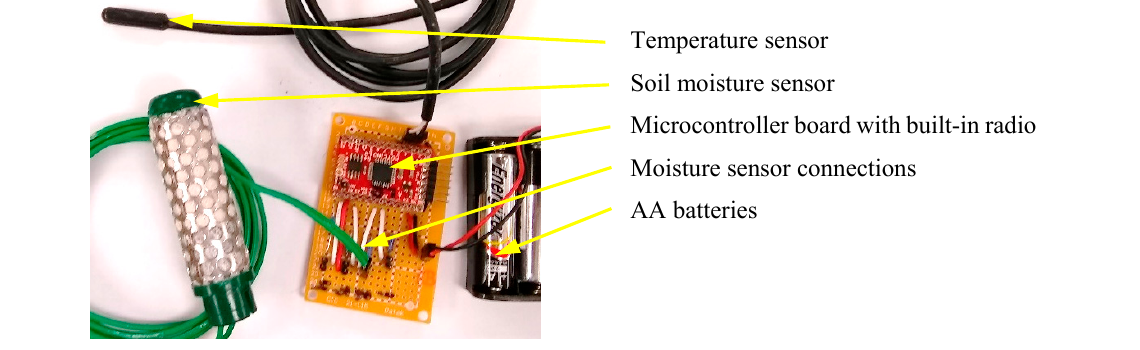
Figure 3. Sensor node. Figure 3. Sensor